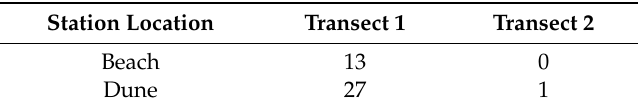
Figure 6. Aerial photo showing the location of transects 1 and 2 (T1, T2) as black lines and associated LWD coverage. LWD coverage is defined as the amount of plan-view surface area covered by LWD, extending 1 m on either side of the transect and 20 m seaward from the dune station. The arrow next to the reference station (i.e., not under the influence of LWD) indicates the average incoming wind direction at 1.5 m. Table 1. Upwind LWD cover densities (%) based on average incoming wind direction of 28° (relative to crestline) by transect (lines) and station location (dots).